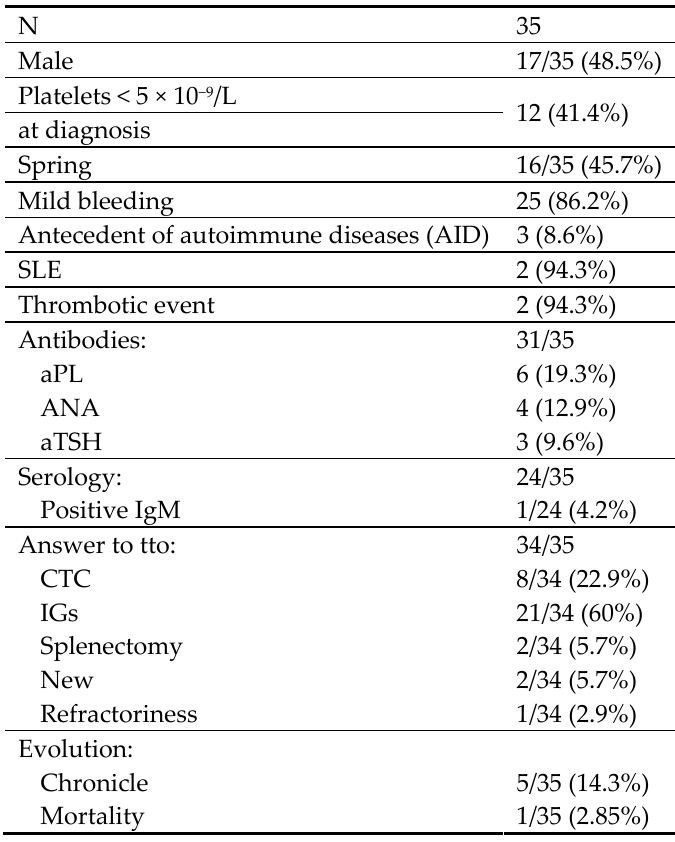
Table 1. Characteristics of the 35